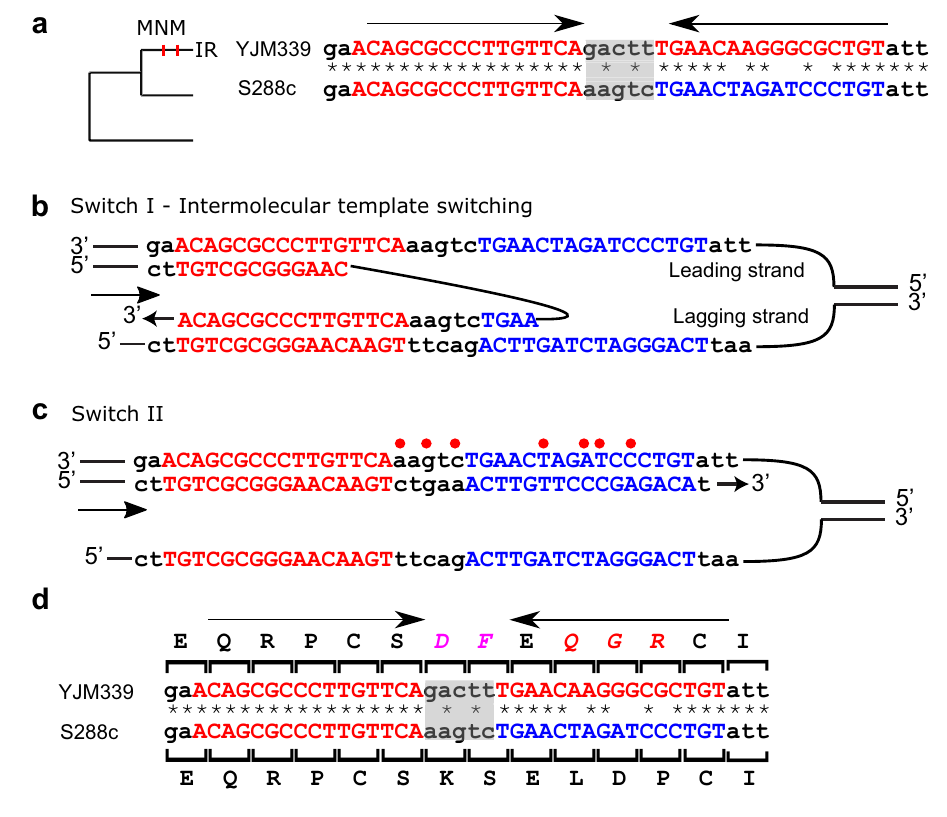
Figure 4. Intermolecular template switching causes arm homogenization and spacer inversion. ( a ) REG2 has a perfect IR with an arm length of 16 bp in YHM339. The ancestral form represented by S288c has an arm length of 5 bp. The MNM occurred on the IR arm in the branch leading to YHM339 (shown as vertical lines on tree). ( b ) Intermolecular template switching, in which the first switch occurred during the synthesis of the first arm, was responsible for spacer inversion. ( c ) The second switch returned the nascent strand to the original template, resulting in an inverted spacer of YHM339 compared to S288c. ( d ) Seven substitutions were induced by this event (three on the spacer and four on the arm, two of which were part of a continuous MNM) resulting in five modified amino acids (KSELDP → DFEQRR, positions